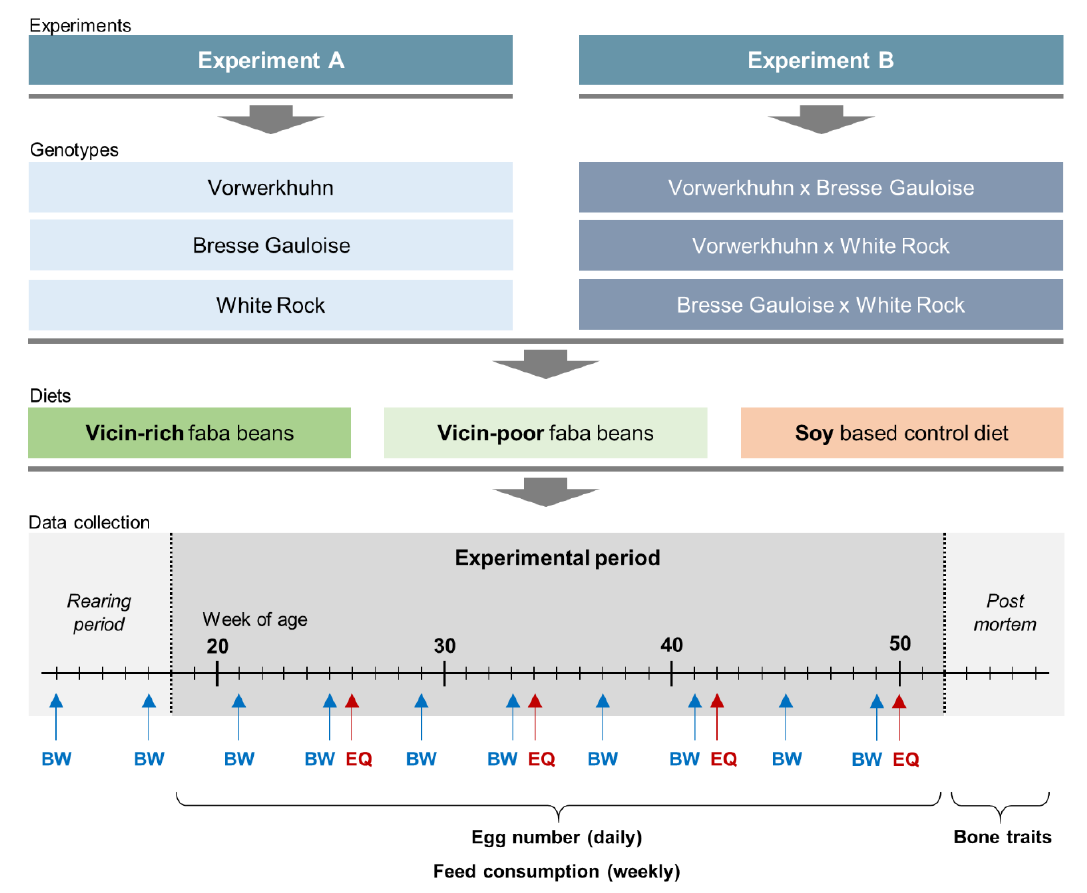
Figure 1. Schematic illustration of the experimental setup. In experiment A, three purebred chicken genotypes were allocated to one of three diets containing either faba beans differing in their vicin content or soybean. Experiment B comprised three crossbred genotypes, which were allocated to the same diets. In experiment A (B), 120 (132) hens per genotype were tested with two replicates per genotype × diet combination consisting of 20 (22) hens each. The data collection was identical in both experiments. Data on egg number, egg quality (EQ), feed consumption and body weight (BW) were collected as indicated. Post mortem, bone morphometry, bone mineral density, bone breaking strength and the cortical bone proportion were assessed. Table 1. Composition, analyzed and calculated nutrient composition of the experimental diets.